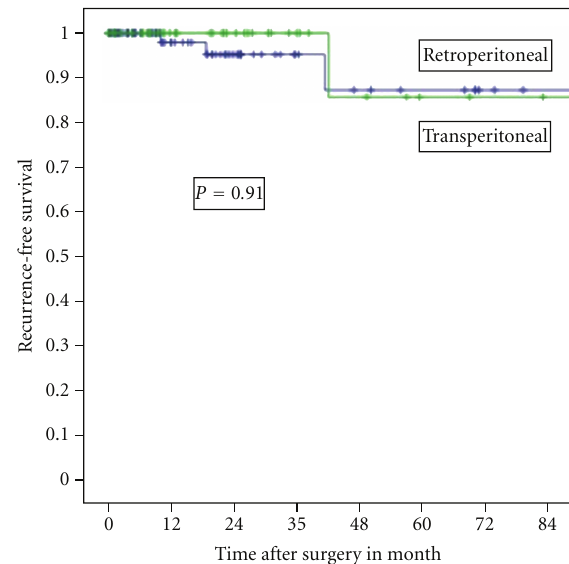
Figure 1: Recurrence-free survival stratified by type of surgery.